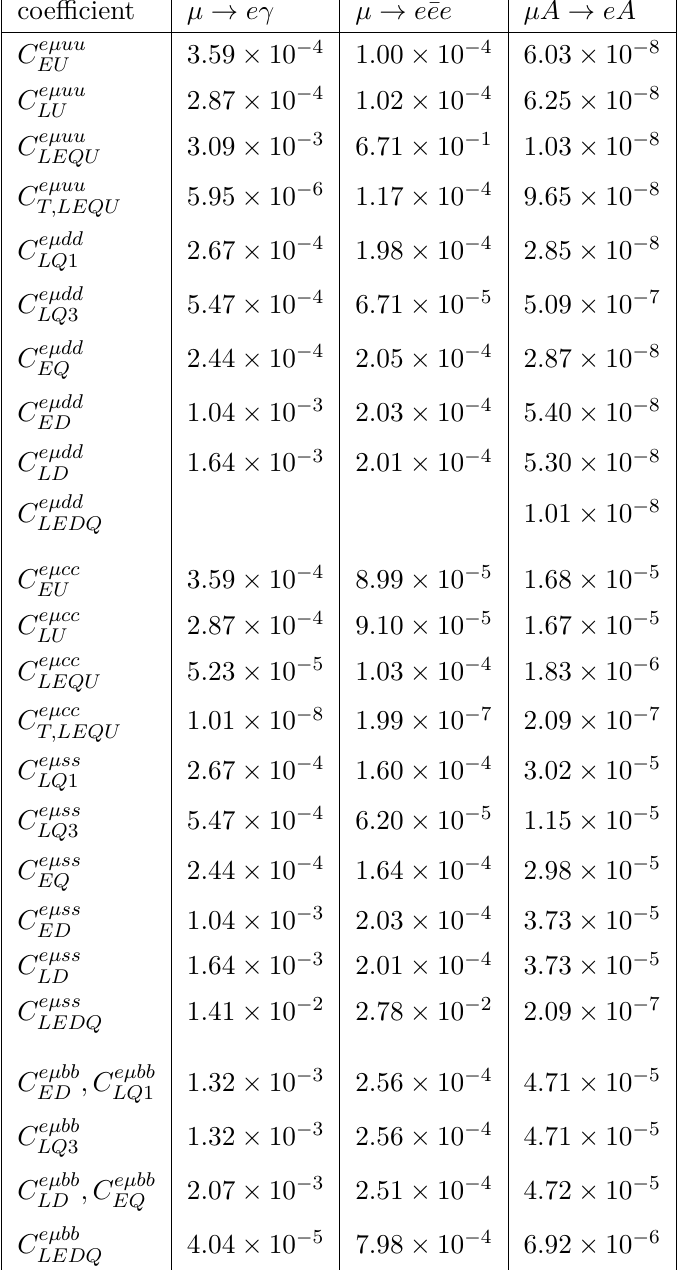
Table 7 . Current sensitivities of µ → eγ , µ → e ¯ ee , and µA → eA to the coefficients of SMEFT operators at m W